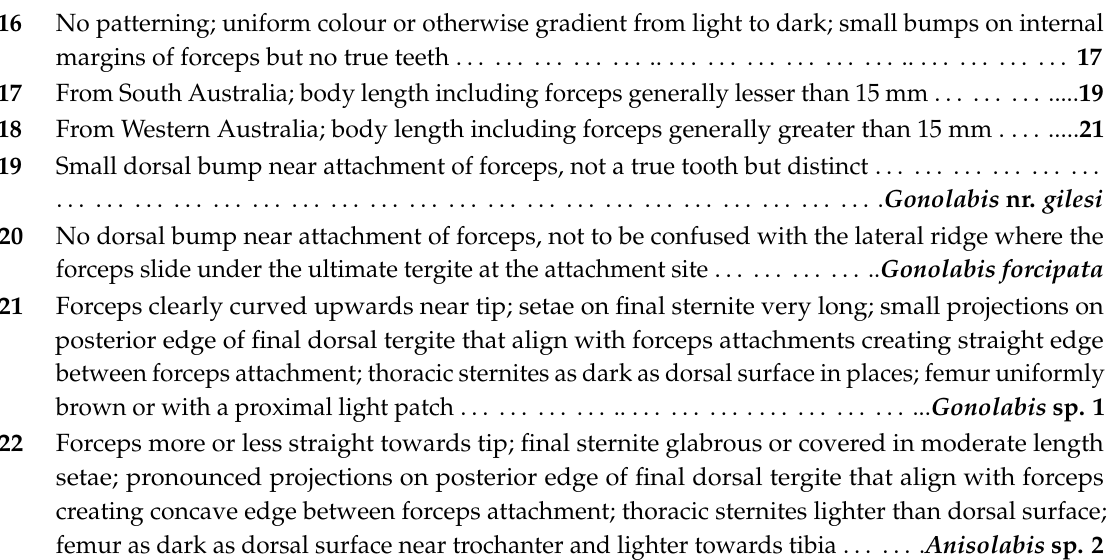
No patterning; uniform colour or otherwise gradient from light to dark; small bumps on internal